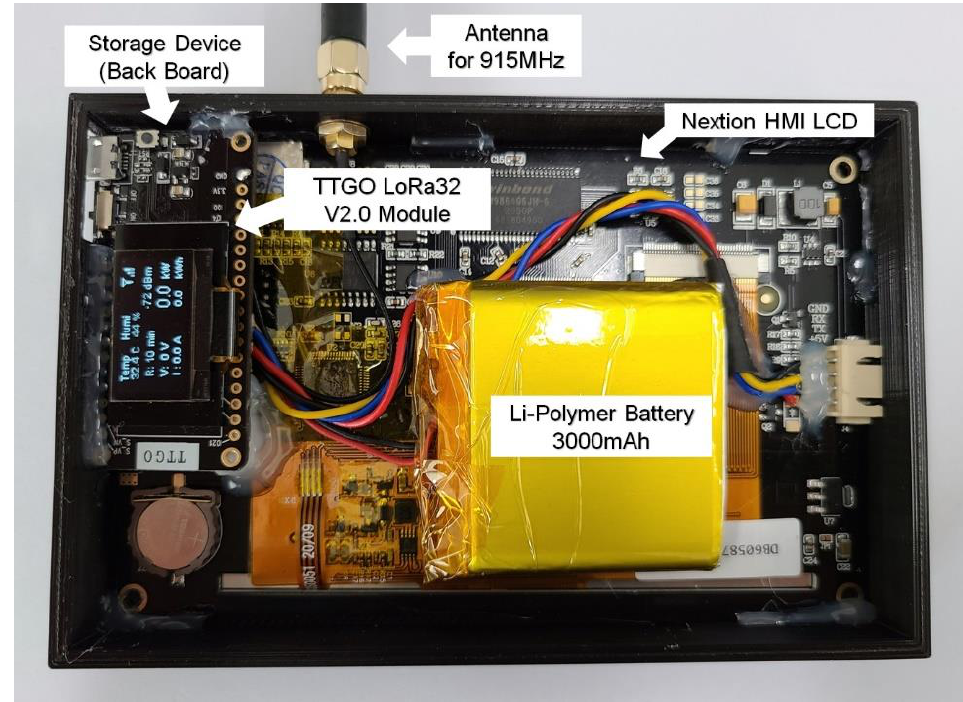
Figure 8. The manufactured RX module, including TTGO LoRa32 V2.0 module, LCD screen, Li-Pol battery, etc.